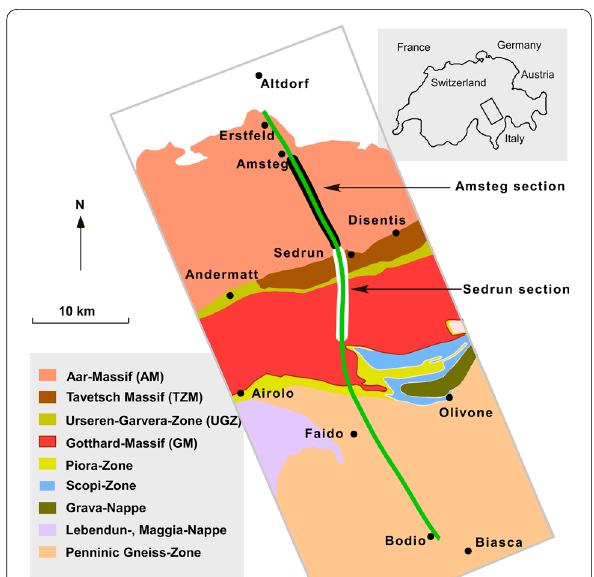
Fig. 1 Schematic geological map showing the course of the Gotthard Rail Base Tunnel. The Sedrun section is highlighted in white, the Amsteg section in black. The tunnel traverses from north to south Pre-Alpine basement of the Aar-Massif (AM), the Tavetsch Intermediate Massif (Tavetscher Zwischenmassiv, TZM), the Gotthard-Massif (GM), and the Penninic Gneiss-Zone. These basement units are separated by in part young-Paleozoic and Mesozoic sedimentary units of the Clavaniev-Zone (CZ), the Urseren-Garvera-Zone (UGZ), and the Piora-Zone. Tertiary Alpine orogeny deformed the Pre-Alpine basement and N-S compression resulted in steeply dipping units (Fig. 2) and E-W trending foliation (Steck & Hunziker,